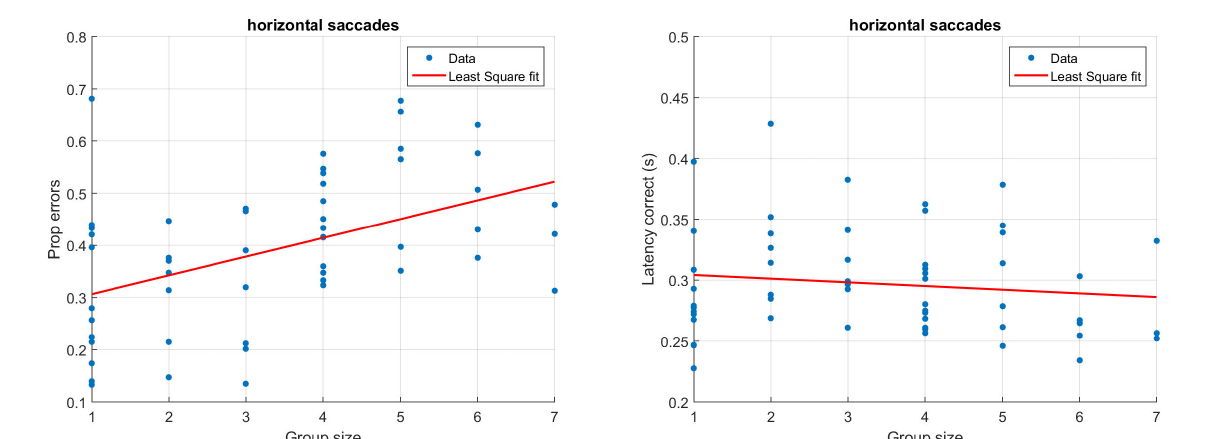
Figure 3 . Proportion of antisaccade errors (left) and latency of correct antisaccades (right) for horizontal saccades. Each dot represents average results from one participant.